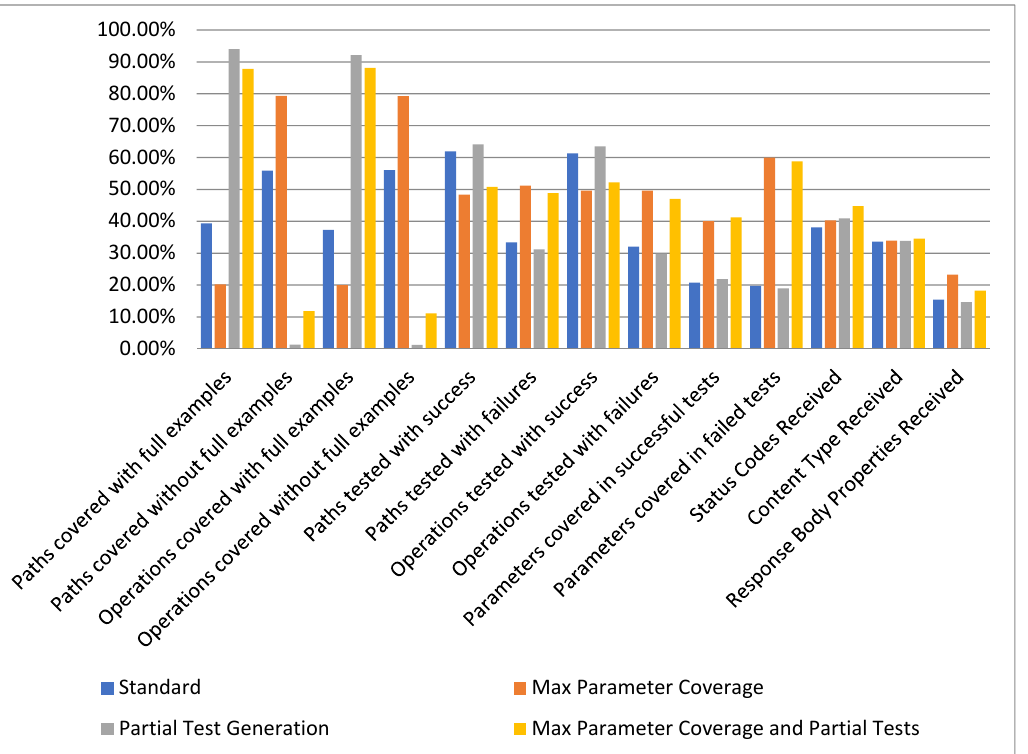
Figure 16. Overview statistics.